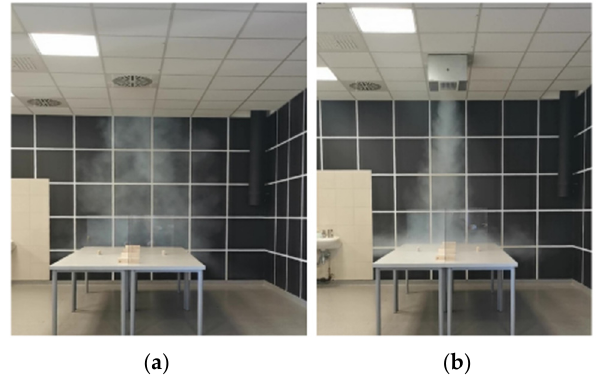
Figure 10. Air Flow pattern without ( a ) and with the air-jet control box ( b ) examined with the “Is- land of four” setup.